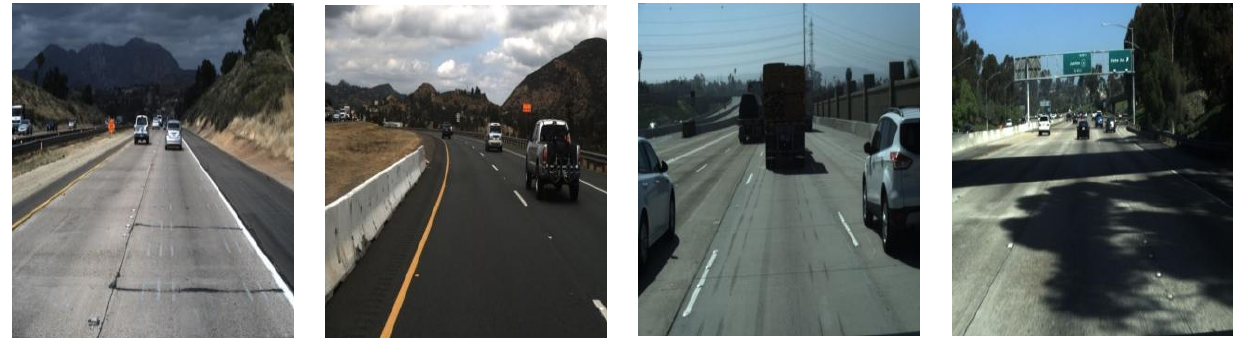
Figure 9. Display of some scenes from the TuSimple dataset.